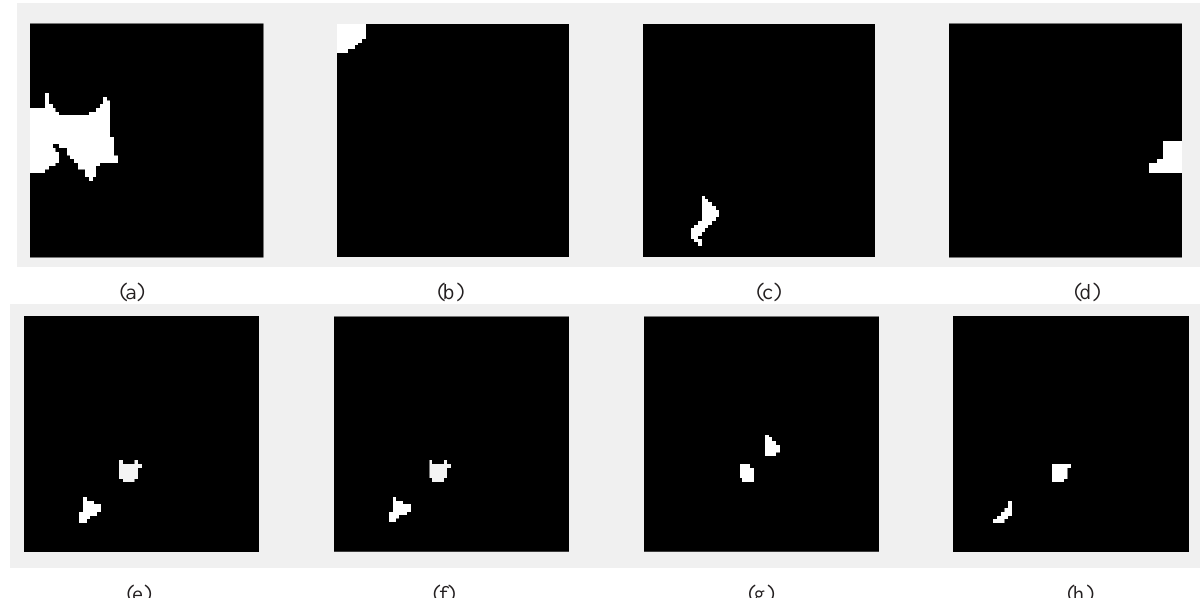
Figure 6. Detection maps of the simulated data 2 (with gaussian white noise 30dB SNR) in different segmentation results corresponding to Fig. 5.